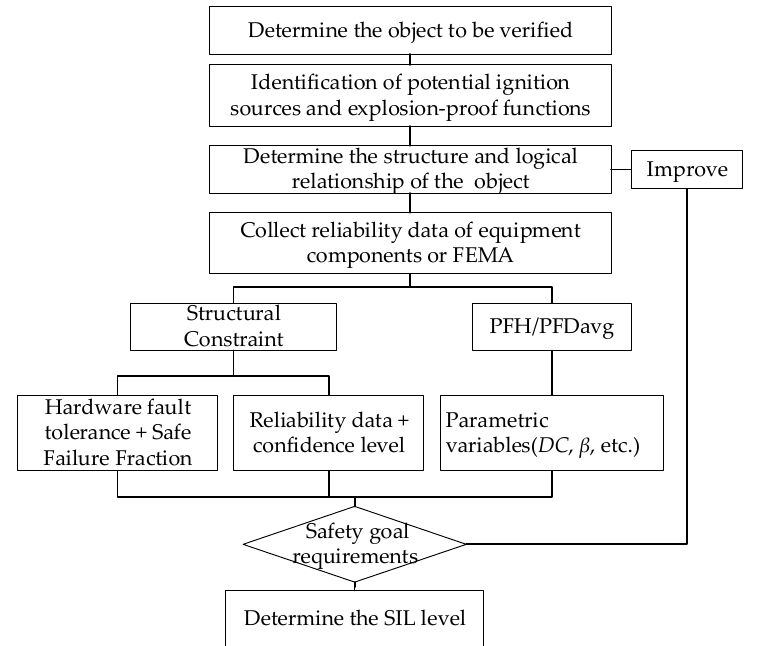
Figure 2. Flow chart of safety integrity level (SIL) verification for explosion protection functions. PFD, probability of a failure on demand; PFH, probability of a dangerous failure per hour; avg, average; FMEA, failure mode and effect analysis; DC , diagnostic coverage; β , beta.